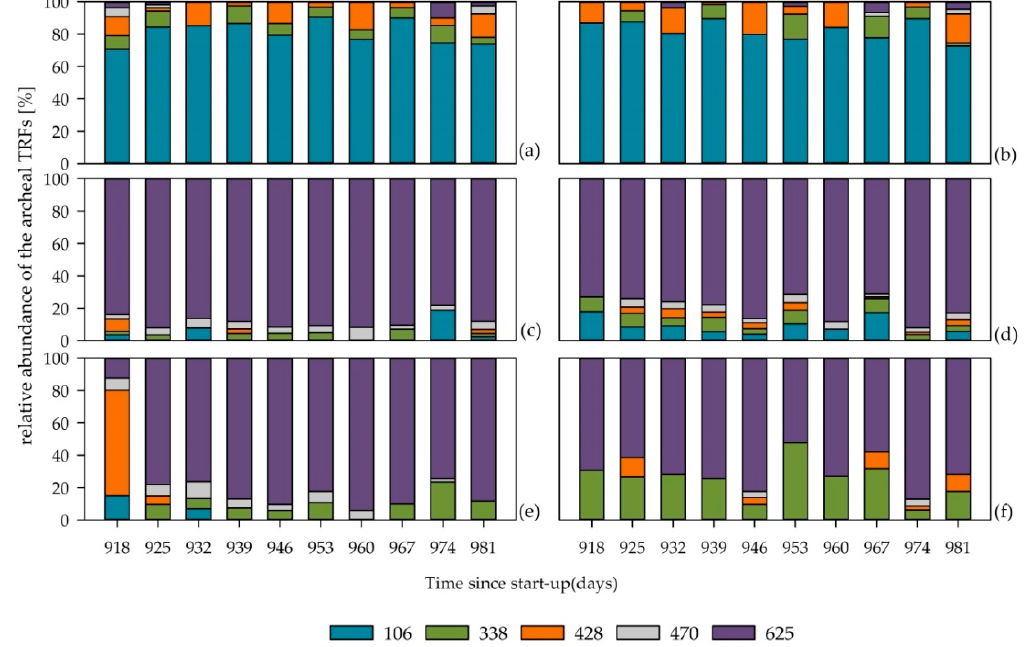
Figure 5. Structure of the archaeal community in reactors SB-M1 ( a ), M-SB1 ( b ), SB-M2 ( c ), M-SB2 ( d ), SB-M3 ( e ), and M-SB3 ( f ). Colored bars symbolize the detected terminal restriction fragments (TRFs) in base pairs (bp) and their relative abundance. Each sampling point is given as a median value of three technical replicates. Numbers in sampling point descriptors indicate the duration of continuous fermentation in days since start-up.